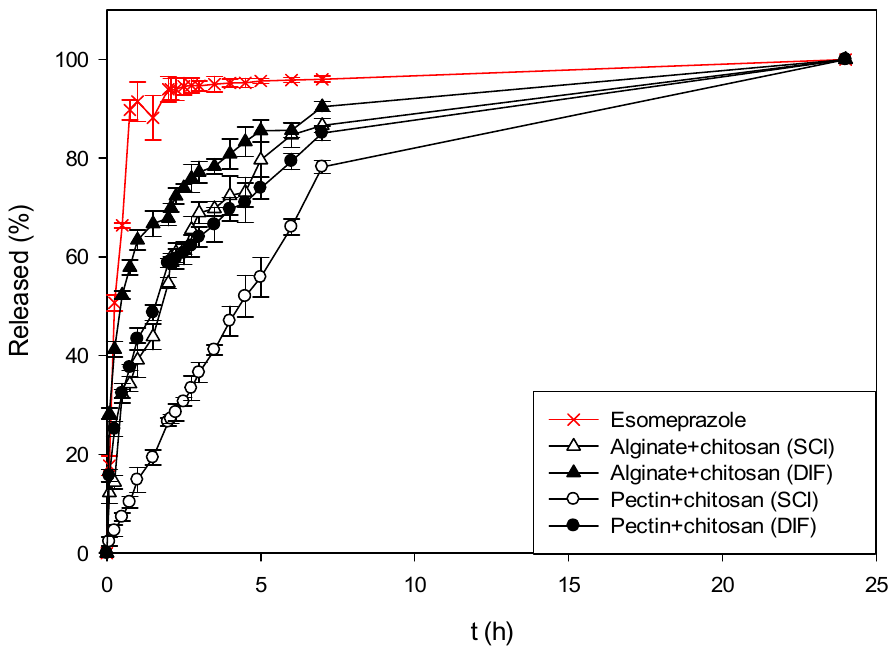
Figure 7. Dissolution profiles of pure esomeprazole and esomeprazole impregnated into alginate and pectin aerogels coated with chitosan using both impregnation techniques.